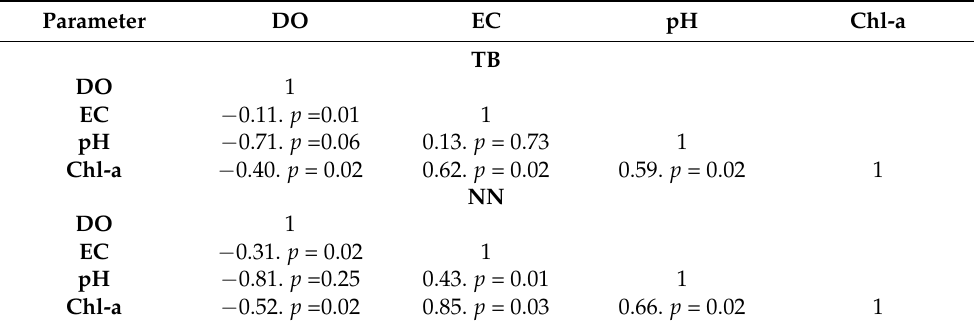
Table 3. Correlation of variability of selected quality parameters for average values calculated for both TB and NN variants, along the transect